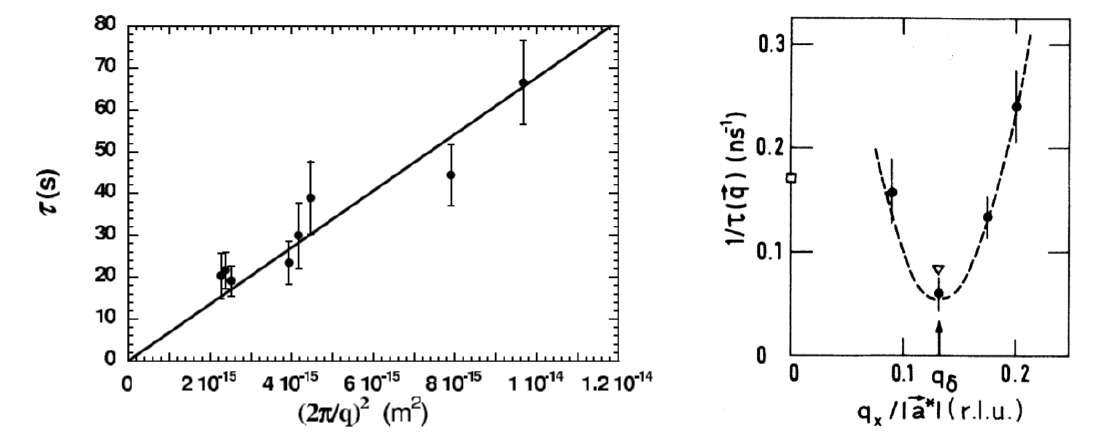
Figure 3: Experimental evidences for the diffusive nature of the phasons. Left: Pha- son relaxation time τ in function of the momentum q in the i-AlPdMn icosahedral quasicrystal at T = 650 ◦ C from [ 63 ] . Right: Relaxation rate τ − 1 ( q ) for NaNO + 0.55 K from [ 64 ] T = T incomm .